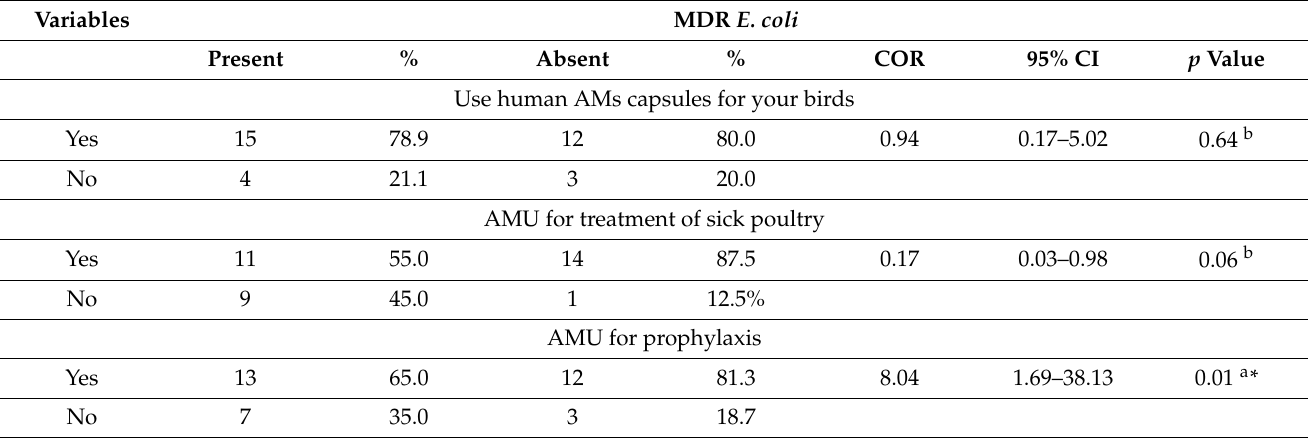
Table 7. Bivariate analysis of risk factors associated with MDR E. coli isolates collected from LBMs in Abeokuta, Ogun